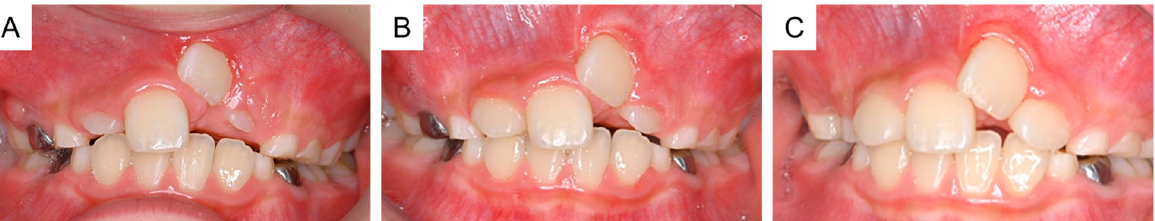
Figure 6. Intraoral photographs of the postoperative period. ( A ) One month after surgical exposure creation (8 years and 10 months of age). ( B ) Two months after surgical exposure creation (9 years and 0 months). ( C ) Four months after surgical exposure creation (9 years and 2 months).